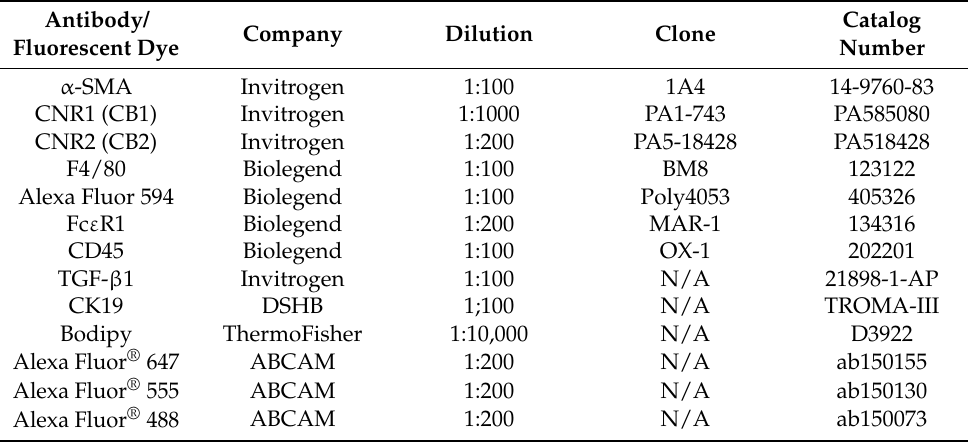
Table 3. Antibodies and fluorescent dyes dilution and